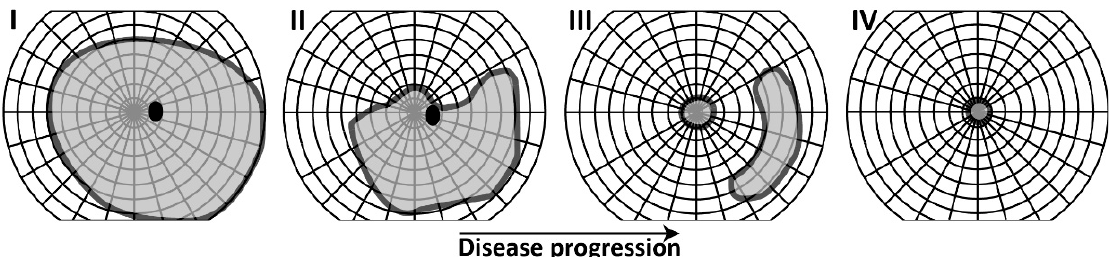
Figure 2. Illustrative example of typical visual fi eld progression in a patient with retinitis pigmentosa using kinetic perimetry. Visual fi elds can be within normal limits in early stages of disease ( I ), although visual fi eld defects may already be present but not detectable within the used target stimulus. With time, constriction of the visual fi elds occurs, with defects typically being symmetric and expanding more rapidly outwards and slower inwards ( II – III ). Ultimately, a small central remnant of visual fi eld may remain in end-stage retinitis pigmentosa, which is commonly experienced and known as ‘tunnel vision’ ( IV ). Note that the clinical course of visual fi eld loss varies between individuals and may follow a progression pa tt ern that is di ff erent from this illustration.